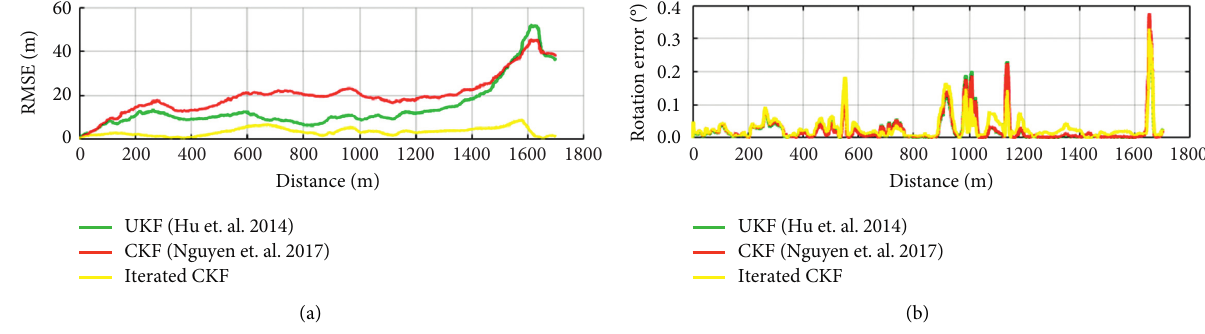
Figure 12: RMSE (a) and rotation error (b) in the experiment with dataset